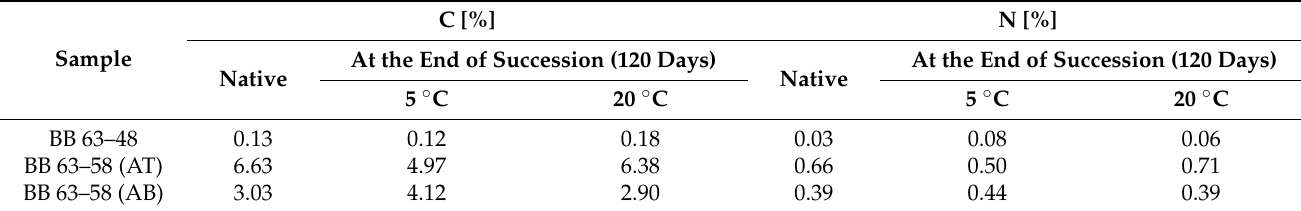
Table 2. The total content of carbon, nitrogen in the studied samples.